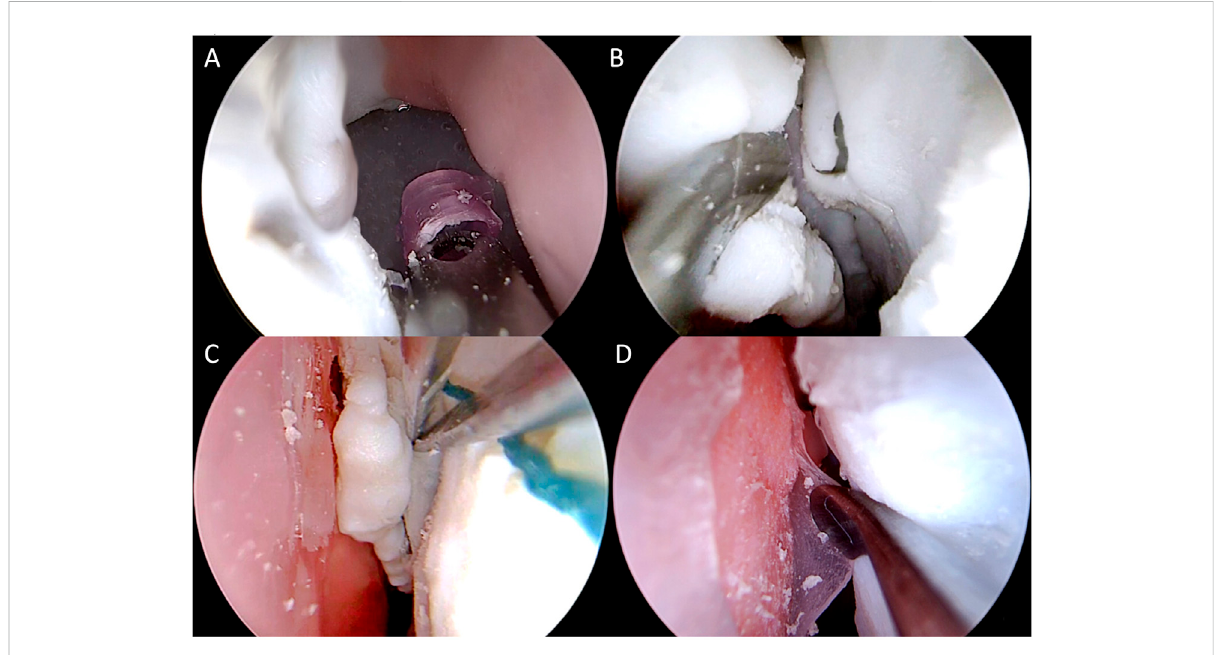
FIGURE 9 Intraoperative endoscopicimagesofnon-destructivetasks. (A) removal ofaplasticforeign bodyfrom therightchoana; (B) medialization ofthe left middle turbinate; (C) insertion of a cottonoid into the left middle meatus; (D) detachment of the simulated septal mucosa from the underlying nasal septum of the left nasal